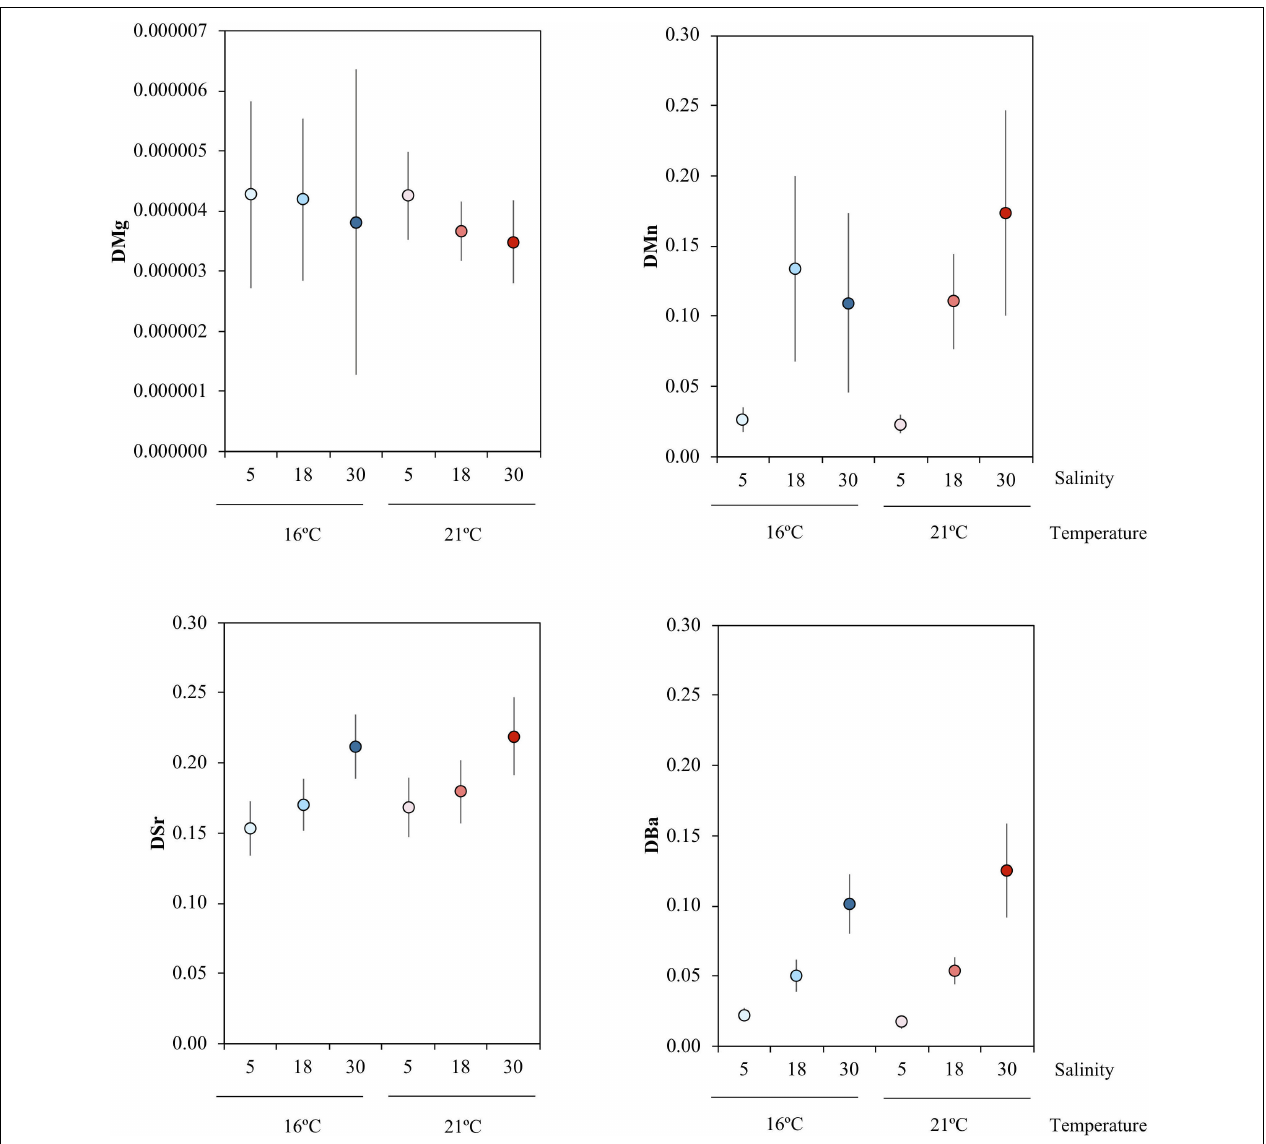
FIGURE 3 | Mean and standard error of partition coefficients of magnesium (D Mg ), manganese (D Mn ), strontium (D Sr ) and barium (D Ba ), across the salinity (5, 18, 30) and temperature (16 and 21 ◦ C) experimental treatments, which are indicated by the different colors: blue colors – 16 ◦ C, red colors – 21 ◦ C; light tone – 5 salinity, medium tone – 18 salinity, dark tone – 30